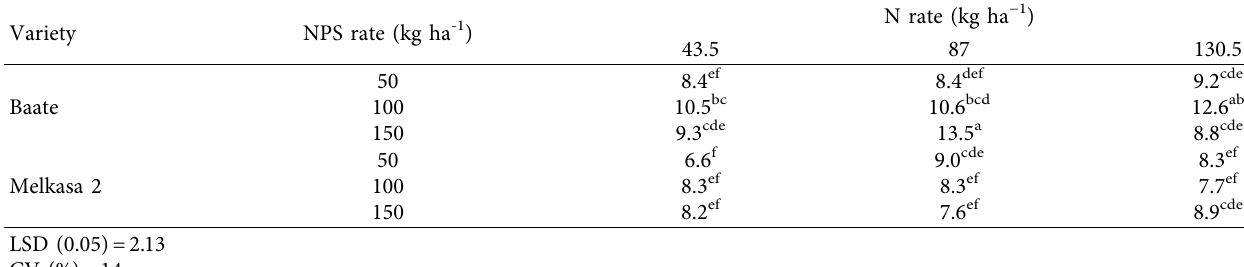
Table 9: Mean values of aboveground biomass yield as affected by the interaction effect of variety × NPS × N in the 2018 cropping season. Variety